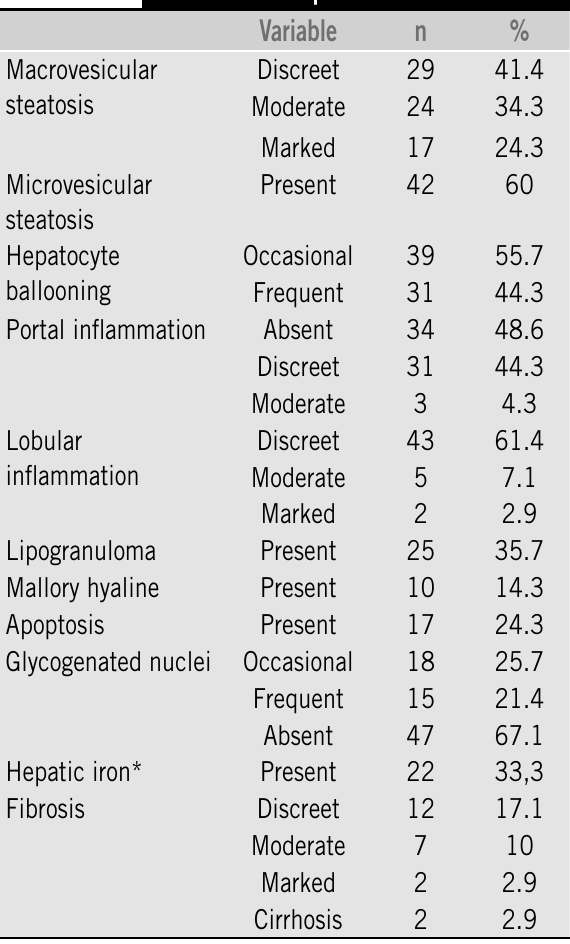
macrovesicular steatosis was diffusely distributed. When diffuse, moderate and marked steatosis predominated (36/46), but cases of mild steatosis (10/46) showing a Results of the histological analysis diffuse distribution in the acinus were also observed.